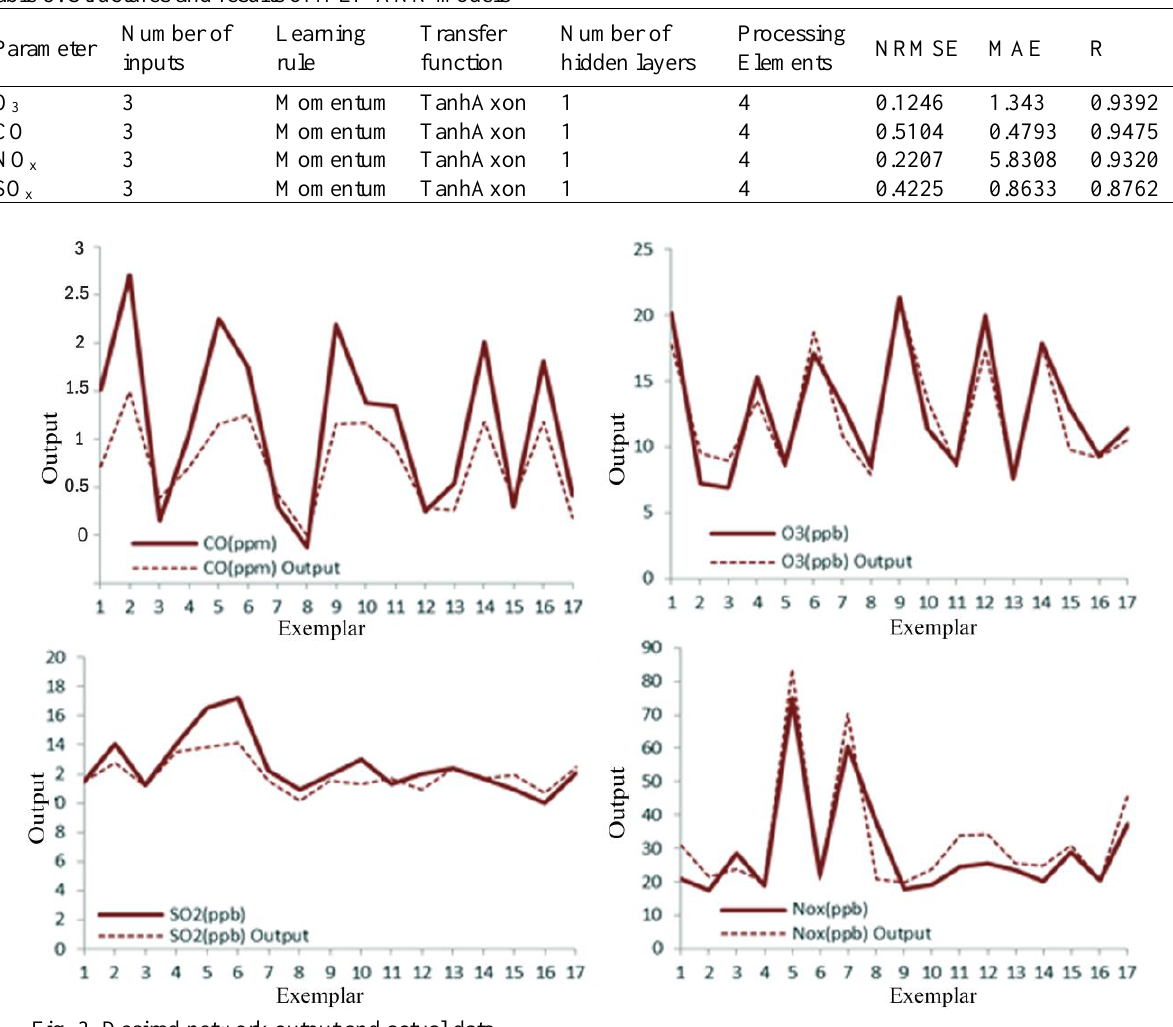
Table 3. Structures and results of MLP-ANN models